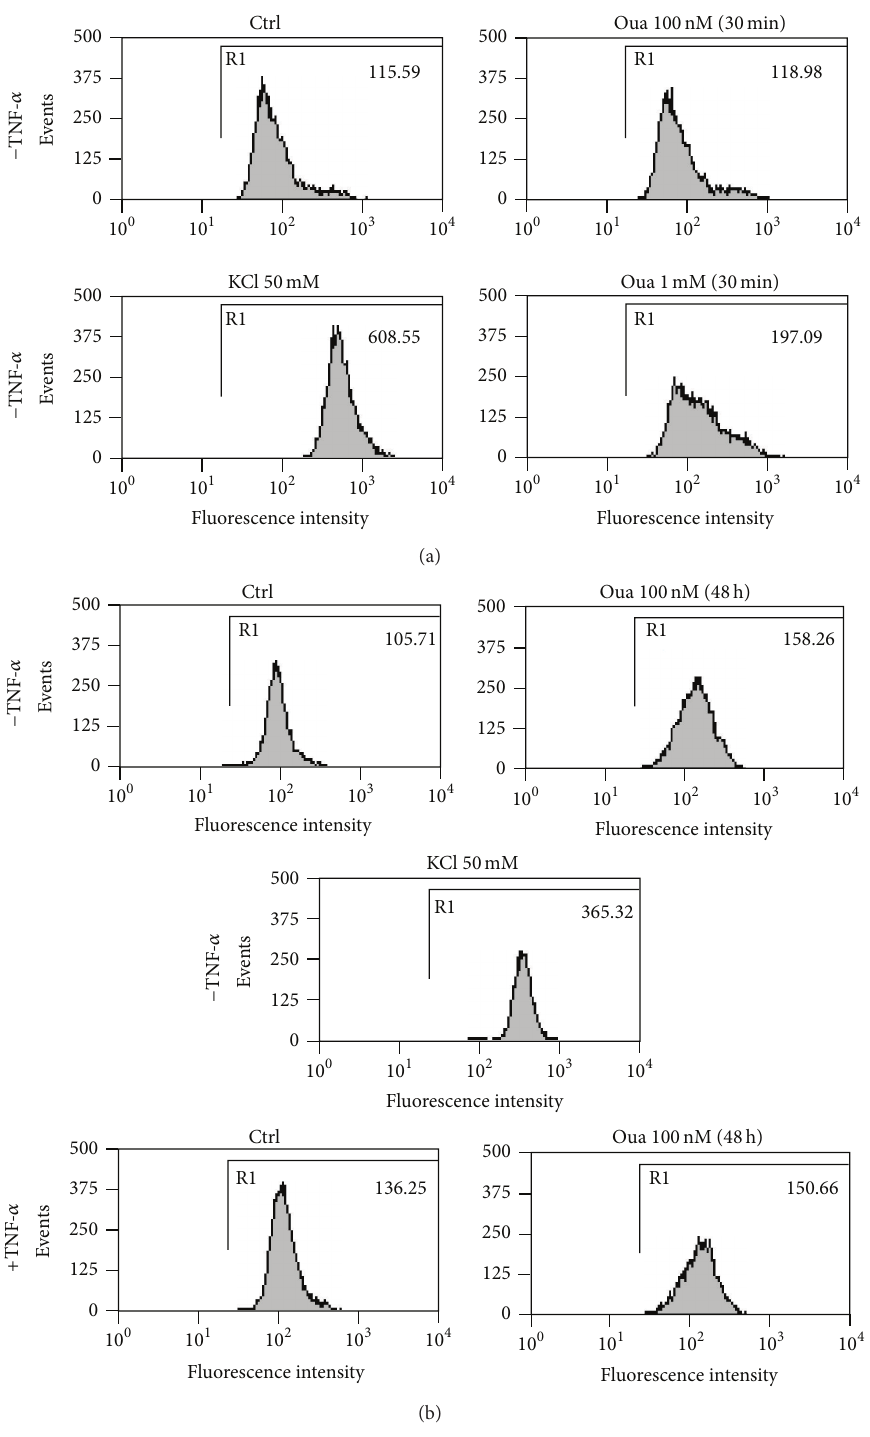
Figure 8: Evaluation of plasma membrane potential in the presence of Ouabain. (a) Differentiated DCs (maintained 5 days with GM-CSF and IL-4) were further incubated in the presence or absence of 100 nM Ouabain or 1mM Ouabain with 250 nM of the fluorescent oxonol dye DIBAC 4 (3) for 30 min. (b) Differentiated DCs were incubated with or without TNF- 𝛼 in the presence or absence of 100nM Ouabain for further 48h. Then, cells were washed, free medium was added, and DCs were incubated with 250 nM DIBAC 4 (3) for 30 min. As a control of membrane depolarization, 50 mMKCl was added for 30 min (during incubation with DIBAC 4 (3)) to the cultures. Next, cells were analysed using flow cytometry, as indicated in Material and Methods section. Data depicts a representative experiment from one individual ((a), 5 independent experiments; (b), 2 independent experiments) and values in each panel refer to the means of fluorescence intensities (MFIs) of DIBAC 4